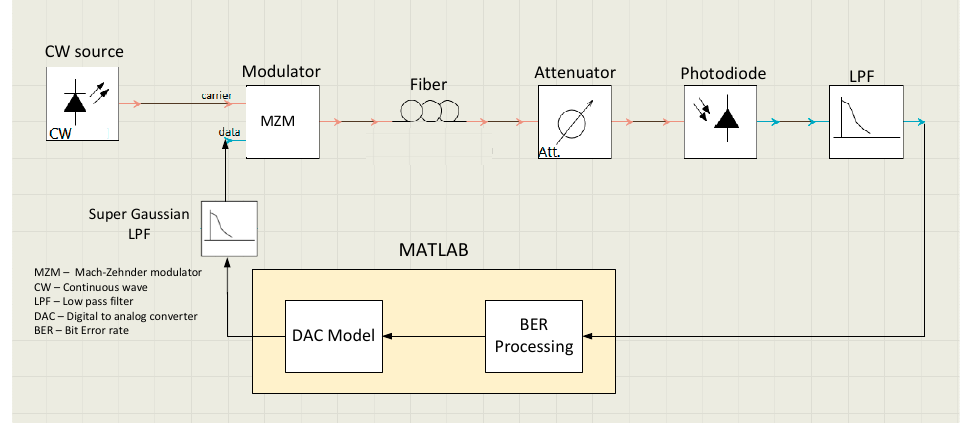
Figure 9. PAM-4 short-reach transmission.